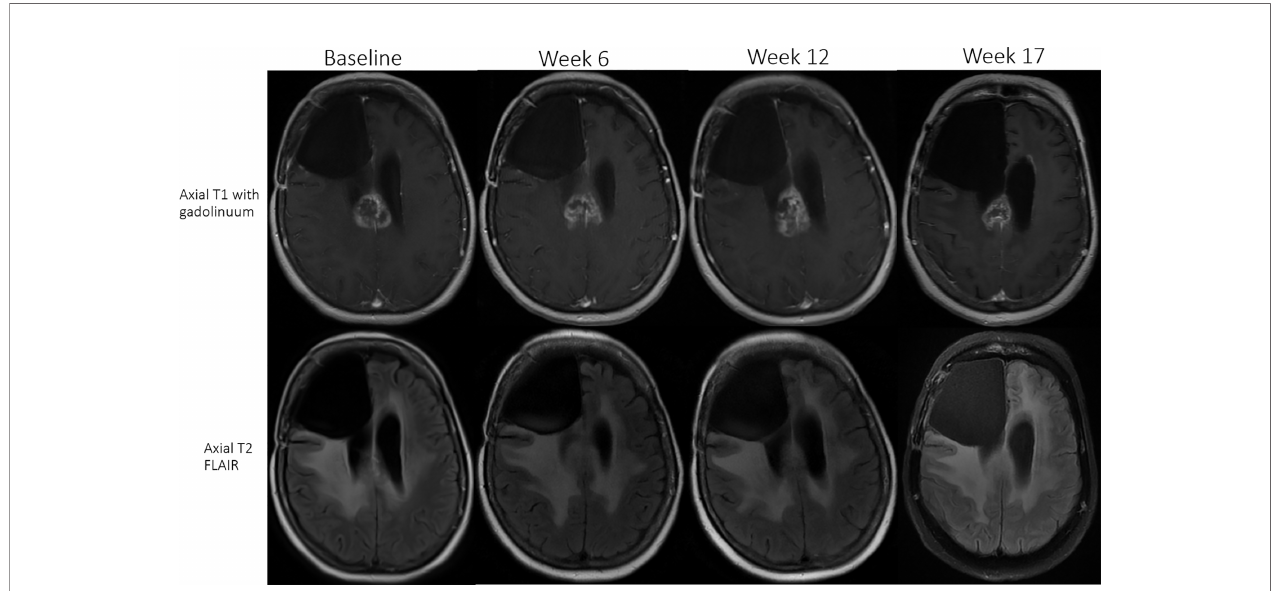
FIGURE 2 | Patient 11 (received nivolumab and ipilimumab) had an initial 27% increase in enhancing lesion burden at fi rst MRI (week 6), 13% decrease at the next follow-up MRI (week 12), and subsequently a 36% decrease (week 17) in size of the enhancing lesion. The patient remained stable on ICB for two additional months until treatment was discontinued due to declining performance status in the setting of a stable MRI scan.